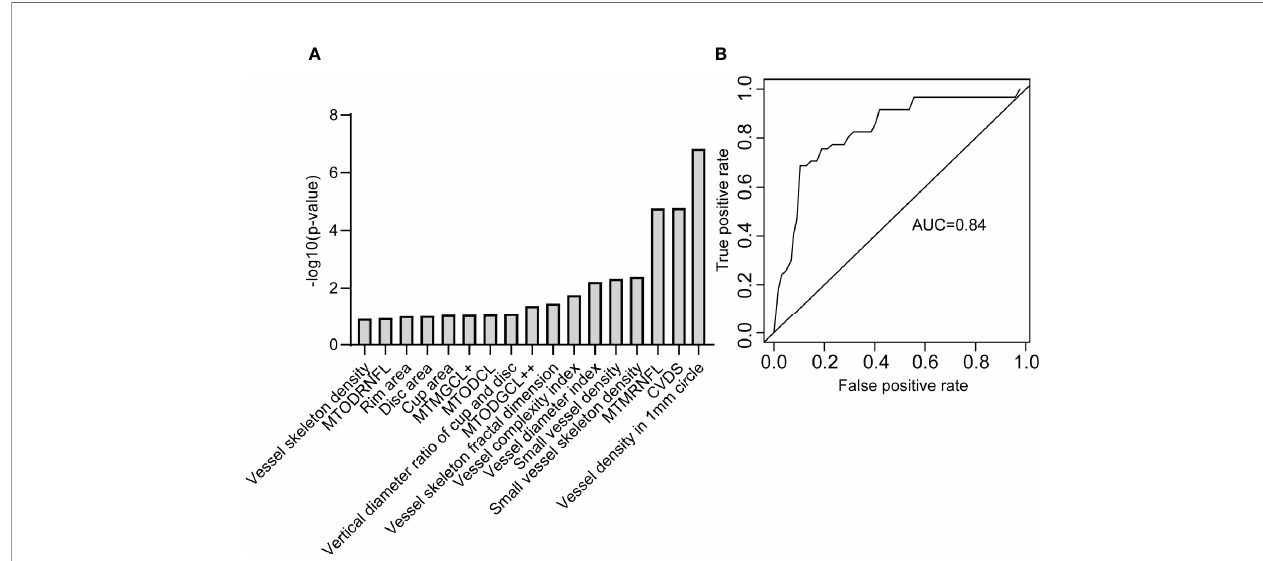
FIGURE 8 | The OCTA metrics related to severe DR. (A) The OCTA metrics related to severe DR and identi fi ed by stepwise regression. (B) The ROC curve of the logistic regression model to distinguish severe DR participants from non-severe DR participants. MTODRNFL, mean thickness of optic disc in the retinal nerve fi ber layer; MTMGCL+, mean thickness of macular in the ganglion cell layer with inner plexiform layer; MTODCL, mean thickness of optic disc in the choroidal layer; MTODGCL++, mean thickness of optic disc in the ganglion cell layer with inner plexiform layer and nerve fi ber layer; MTMRNFL, mean thickness of macular in the retinal nerve fi ber layer; CVDS, center vessel density in the super fi cial